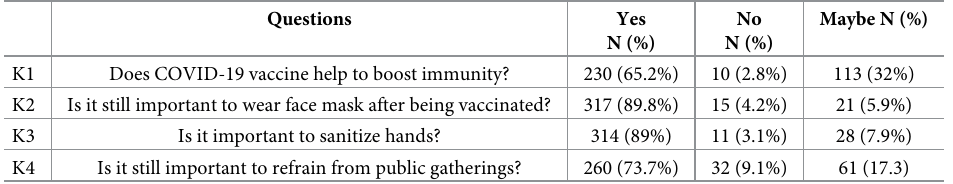
Table 3. Respondents’ knowledge regarding COVID-19 standard operating procedures (SOPs).